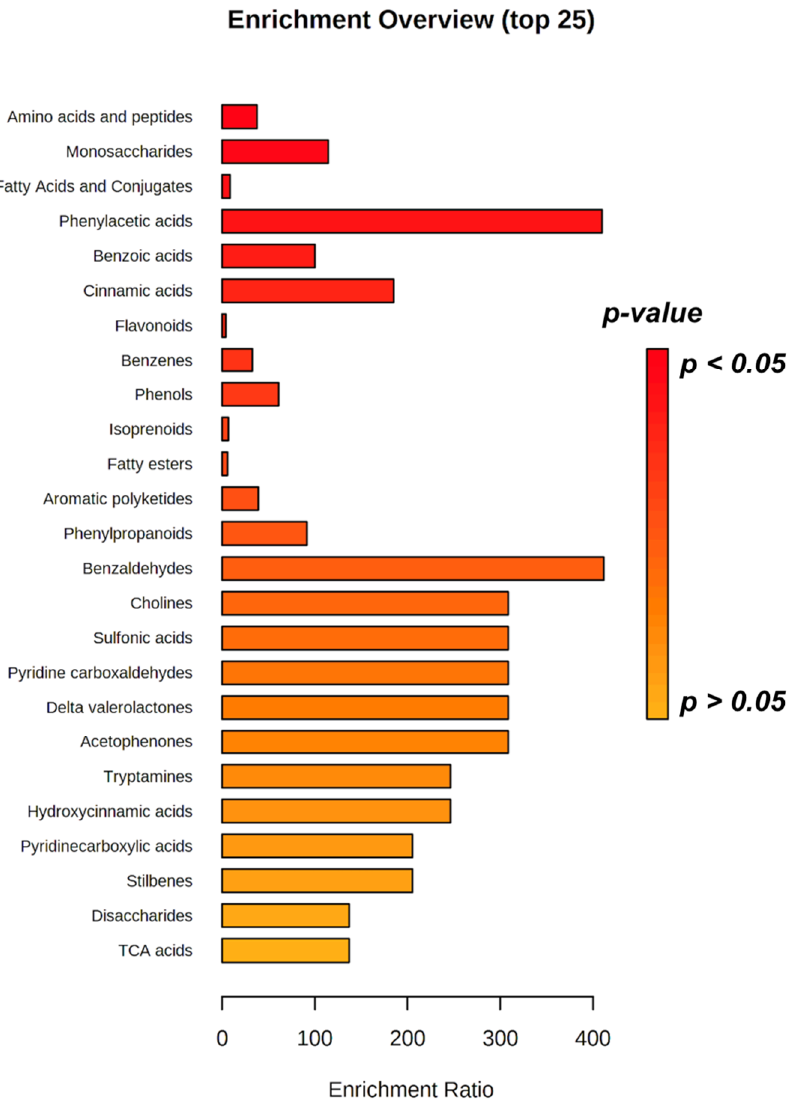
Figure 1. Enriched chemical classes considering sheep milk metabolites annotated by untargeted UHPLC-ESI-QTOF-MS. Abbreviations: tricarboxylic acids (TCA).